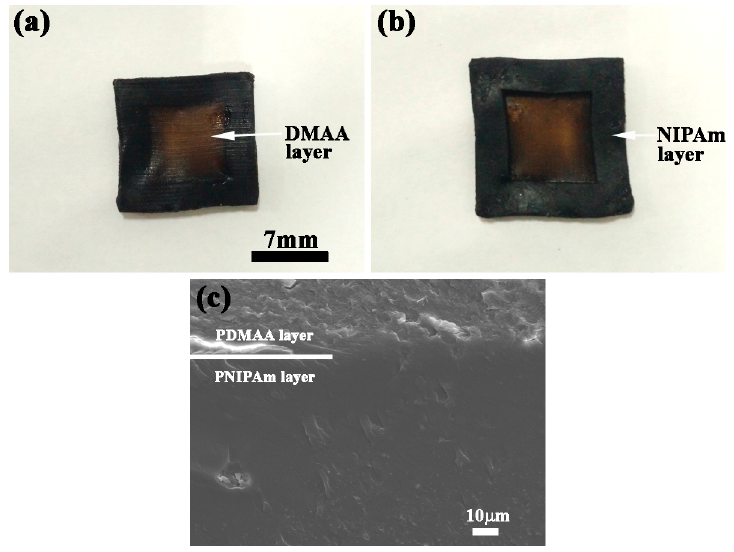
Figure 9. Morphology of ( a ) PDMAA layer; ( b ) PNIPAm layer; and ( c ) the interface bonding characteristics of bilayer hydrogel.